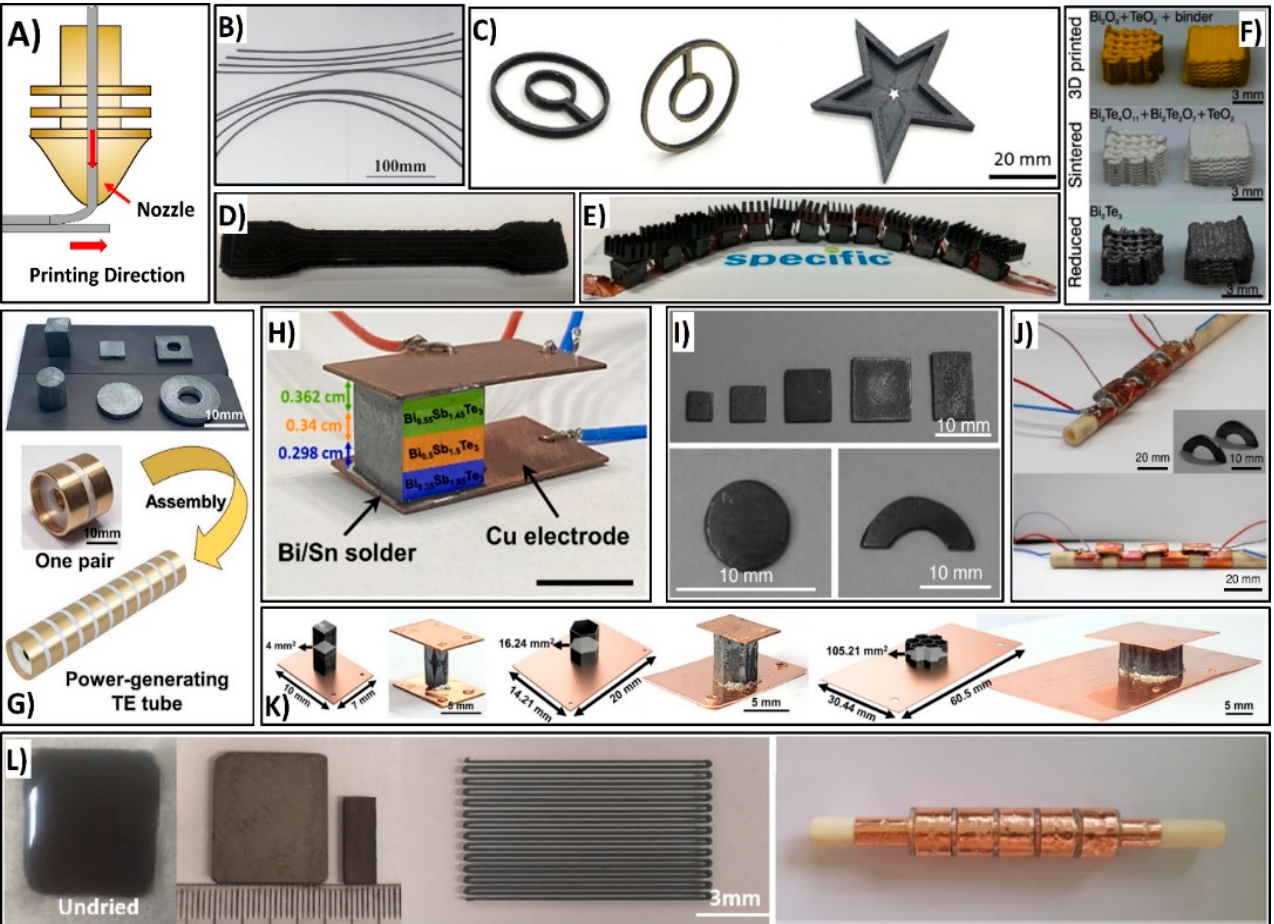
Figure 2. ( A ) Schematic of the working principle of material extrusion, ( B ) Bi 0.5 Sb 1.5 Te 3 /MWCNT based composite filaments (Reprinted with permission from [39] Wang et al.), ( C ) Custom printed Bi 2 Te 3 shapes (Reprinted with permission from [40] Oztan et al.), ( D ) ABS/ZnO composite sample by Aw et al. [41], ( E ) SnSe based TE generator by Burton et al. [26], ( F ) Bulk Bi 2 Te 3 scaffolds (Reprinted with permission from [52]. 2021, Kenel et al.), ( G ) Bulk PbTe samples in various shapes and the resultant functional TE generator by Lee et al. [44] ( H ) Composition-segmented BiSbTe generator (Reprinted with permission from [46]. 2021, Yang et al.), ( I , J ) Bulk samples and the tubular TE generator printed using all-inorganic Bi 2 Te 3 + Sb 2 Te 3 ChaM inks (Reprinted with permission from [43]. 2018, Kim et al.), ( K ) Cuboid, hollow hexagonal column, and honeycomb-shaped printed bulk Cu 2 Se TE legs by Choo et al. [47], ( L ) As-printed and sintered bulk samples and the tubular TE generator based on Bi 2 Te 3 /PVP-Bi 0.5 Sb 1.5 Te 3 /PVP inks (Reprinted with permission from [51]. 2020, Su et